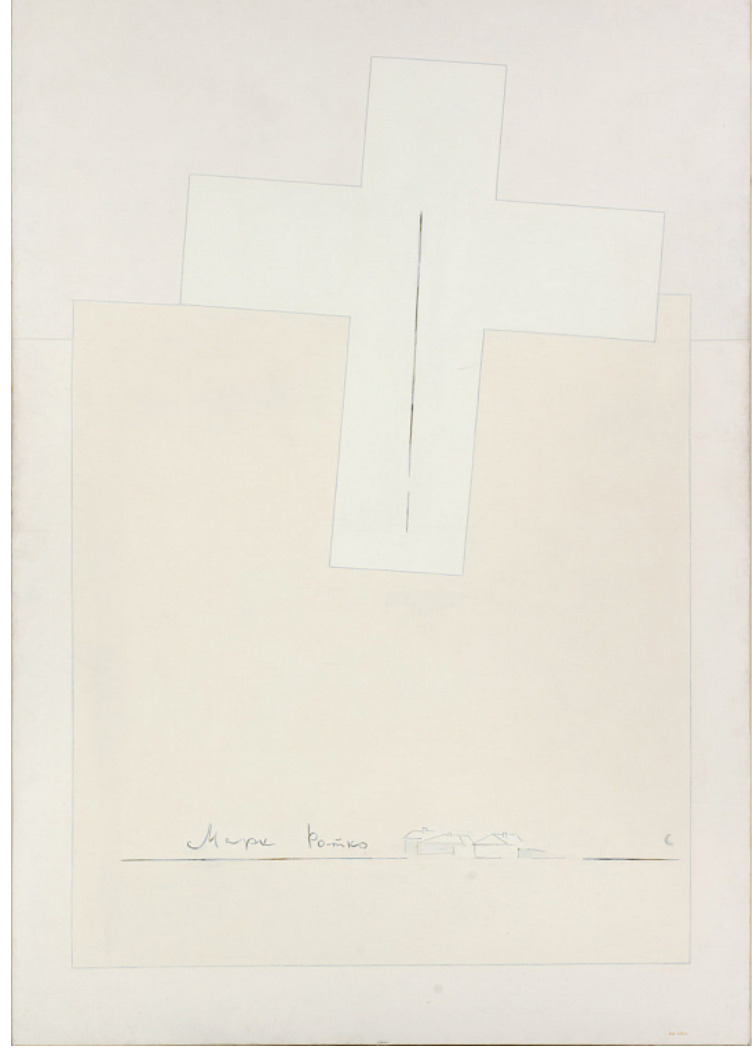
Figure 5. Eduard Steinberg. A Dedication to Rothko, 1999. Oils on canvas, 195 × 130. Art4 Museum, Moscow. https://www.art4.ru/museum/shteynberg-eduard/ (accessed on 22 May 2022).